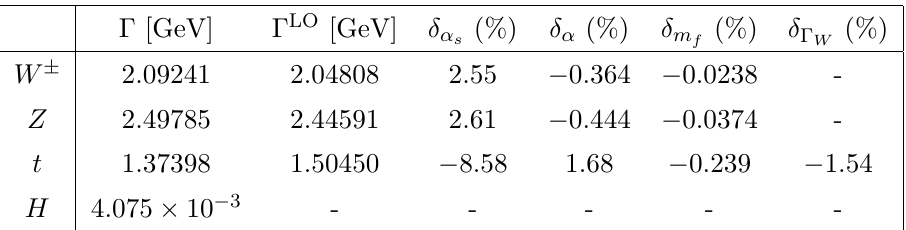
Table 8. As in table 7, for the G (cid:22)